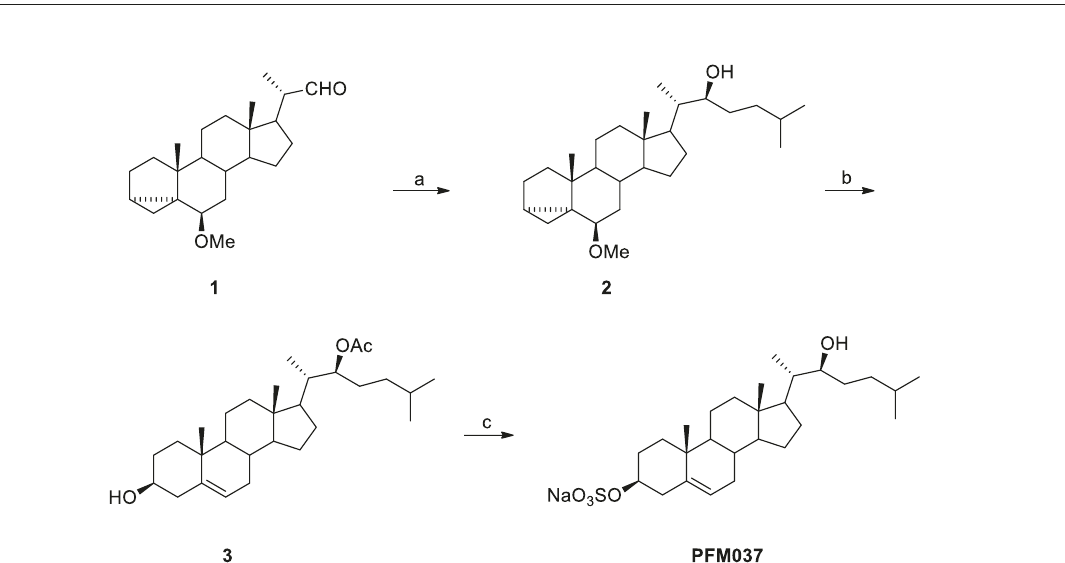
Fig. 9 Synergizing effects of PFM037 and immunotherapy in controlling lung and melanoma tumor growth and analysis of myeloid cells in fi ltrating human tumors. A LLC tumor growth in mice treated with PFM037, anti-PD-1 mAb, the combination therapy, or vehicle plus ctrl mAb ( n = 5 mice/group). *** P < 0.001; **** P < 0.0001; ns, not signi fi cant (Student ’ s t-test). B Overall survival of LLC-bearing mice treated with PFM037, anti-PD-1 mAb, the combination therapy, or vehicle plus ctrl mAb ( n = 6 mice/group). Statistical comparison was performed by log- rank test (vehicle vs anti-PD1, P = 0.0051; vehicle vs P FM037, P = 0.0051; vehicle vs P FM037 + anti-PD1, P = 0.0009). C, D Tumor volume ( C ) and overall survival ( D ) of NOD-SCID mice challenged with LLC-OVA and treated with PFM037 and/or adoptive cell therapy with in vitro activated OT-I T cells ( n = 5 mice/group). For tumor volume ** P = 0.0018; **** P = 0.0001 (Student ’ s t-test). For overall survival statistical comparison was performed by log-rank test (PFM037 vs OT-I, P = 0.0027; PFM037 vs P FM037 + OT-I, P < 0.014; OT-I vs PFM037 + OT-I, not signi fi cant). E B16F1- OVA tumor weight following the treatment with vehicle, PFM037, in vitro activated OT-I alone, or in combination with PFM037 ( n = 5 mice/ group). ** P < 0.01; *** P < 0.001 (Anova). F Average expression heatmap (normalized-UMI) of reverse cholesterol transport (RCT)/cholesterol synthesis genes in NSCLC immune-in fi ltrating cell populations [43]. Insert displays t-SNE plots of all cells pro fi led, color-coded according to the expression of ABCA1 and SCD transcripts in the same populations. G Average expression heatmap (normalized-UMI) of LXR/cholesterol synthesis genes in tumor-associated monocyte/macrophage and DC subsets of myeloid cells [43]. Insert displays t-SNE plots of myeloid cells pro fi led, color-coded according to the expression of ABCA1 and SCD transcripts in the same populations. ( H ) Dot plots of LXR/cholesterol synthesis genes in melanoma-in fi ltrating monocytes and DCs pro fi led, divided in Responder and Non-Responder patient-cells [44]. Each dot is colored according to the expression value and the size is related to the percentage of cells expressing the gene in the population of interest.